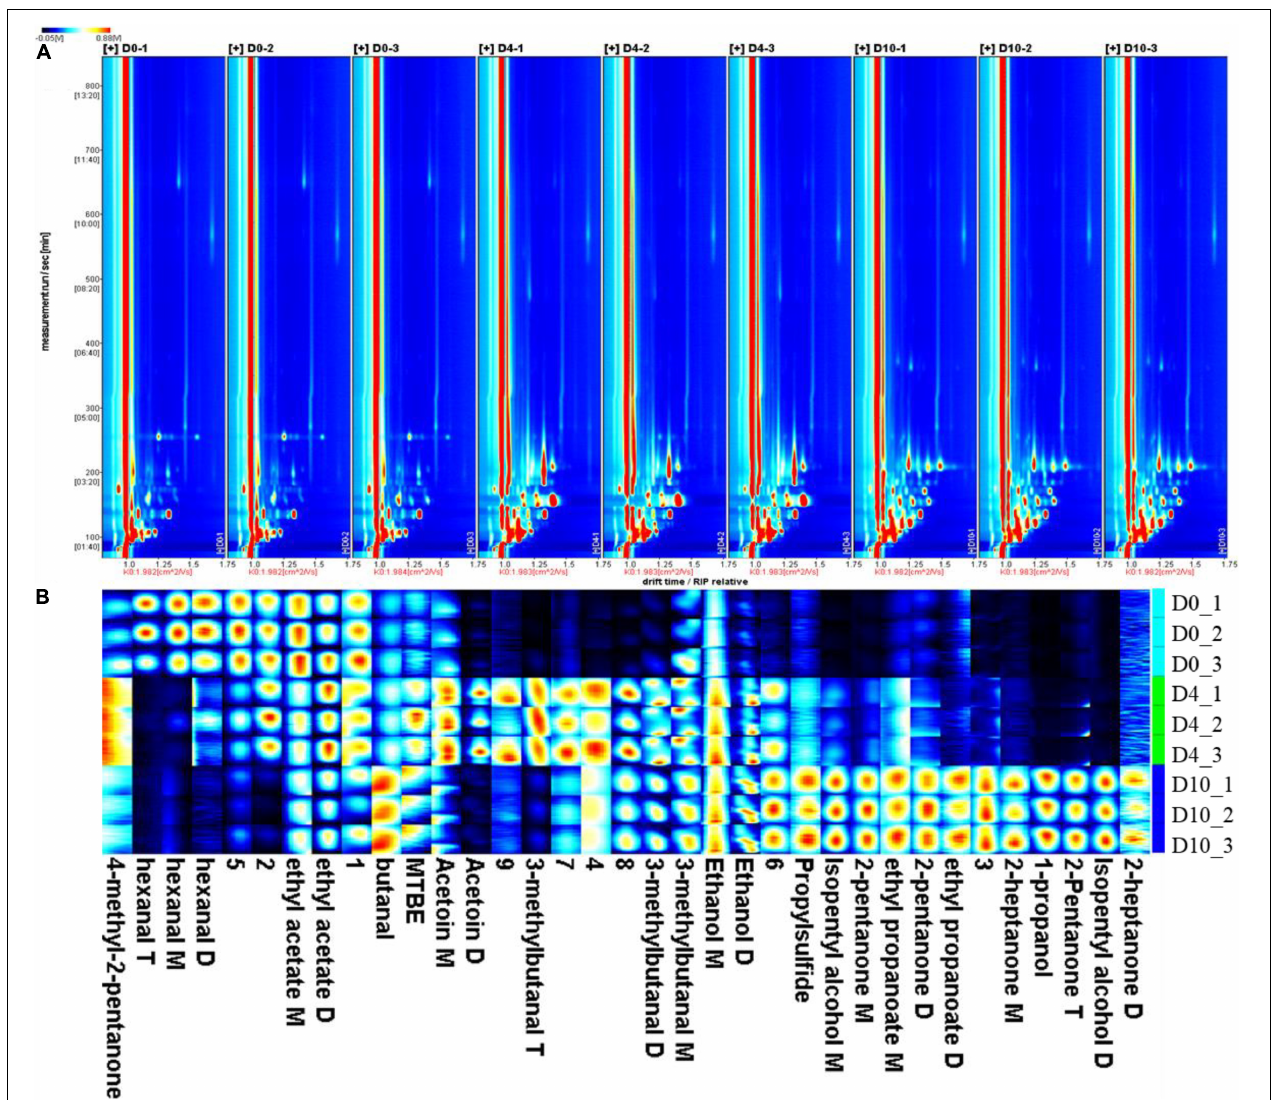
FIGURE 2 | The volatile organic compounds (VOCs) identified in sturgeon filets on days 0, 4, and 10 during storage at 4 ◦ C. (A) Topographical plots corresponding to signals detected in samples and (B) fingerprint comparison of VOCs in samples determined by gas chromatography–ion mobility